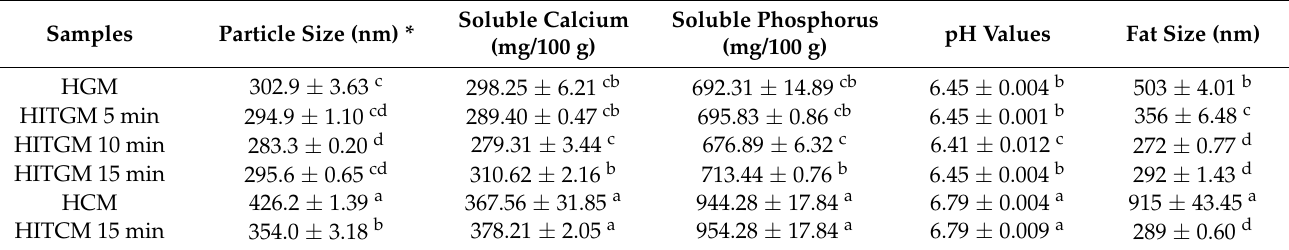
Table 1. Changes in soluble calcium and phosphorus concentrations (mg/100 g) in the water- soluble phase, pH values and fat size (nm) following the high-intensity thermosonication treatments compared to homogenized goat milk and homogenized cow